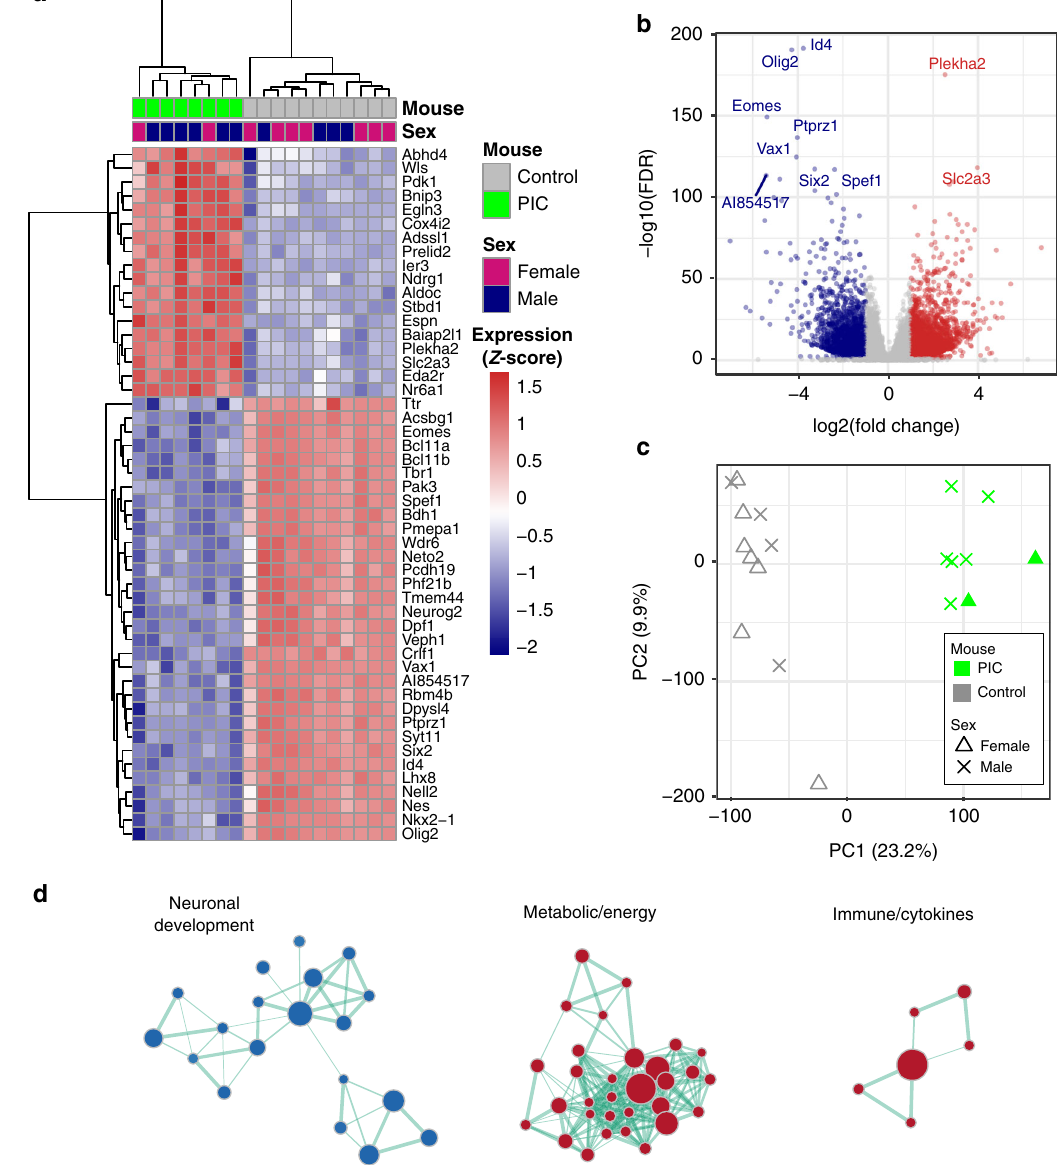
Fig. 2 Transcriptomic dysregulation in the PolyI:C mice model. a Heat map of the 50 most differentially expressed genes (i.e. smallest FDRs) using normalized (separate Z -score computed per gene) TPM expression values. b Volcano plot representing the expression changes of all genes. Signi fi cantly down- and upregulated genes (log 2 FC|>1 and FDR < 0.05) are colored navy and red, respectively. Genes that do not show signi fi cant expression changes are colored gray. Top 10 most differential genes (i.e. smallest FDRs) are labeled with gene names. c PCA analysis. Principal components were computed for each sample using gene expression. The fi rst two principal components (PC1 and PC2) are shown. The percent of variance explained by each component is reported in parentheses. d Gene set enrichment analysis performed on gene ontology (GO) terms, identi fi ed down- and upregulated gene sets. Each node represents one gene set (i.e. a GO term) where the node size indicates the number of genes in the gene set and the color indicates down- (blue) or up- (red) regulation. In summary, the data nodes are clustered based on the number of shared genes between any two gene sets (using the Enrichment map plugin on Cytoscape — see Methods). Three biological modules emerge: (I) neuronal development, (II) metabolic/energy, and (III) immunological. The distances between the nodes and edge thickness indicate the number of shared genes (closer and thicker indicate more shared genes). The following are the largest gene sets in each module: GO FOREBRAIN DEVELOPMENT , GO NUCLEOBASE CONTAINING SMALL MOLECULE METABOLIC PROCESS , and GO REGULATION OF CYTOKINE PRODUCTION for modules I, II, and III respectively. A full list of the gene sets included in this plot are presented in Supplementary Data 3. Source data are provided as a Source Data fi